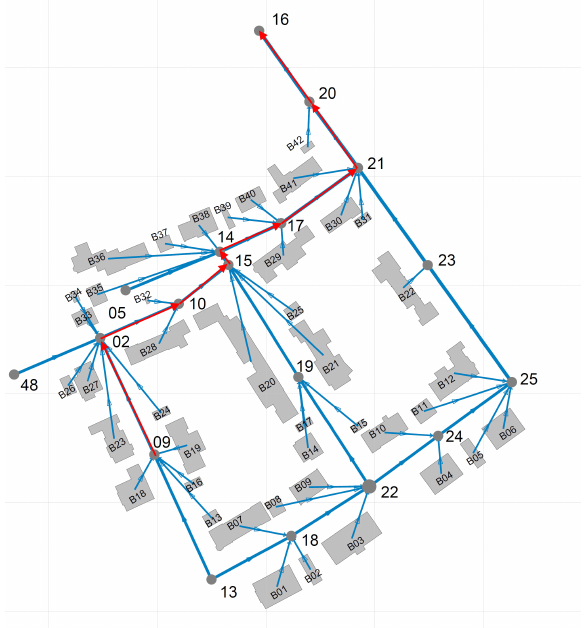
Figure 1. Sewer network of undisclosed sub-catchment area of an European city. Red arrows indicate the flow path starting from manhole No. 09.